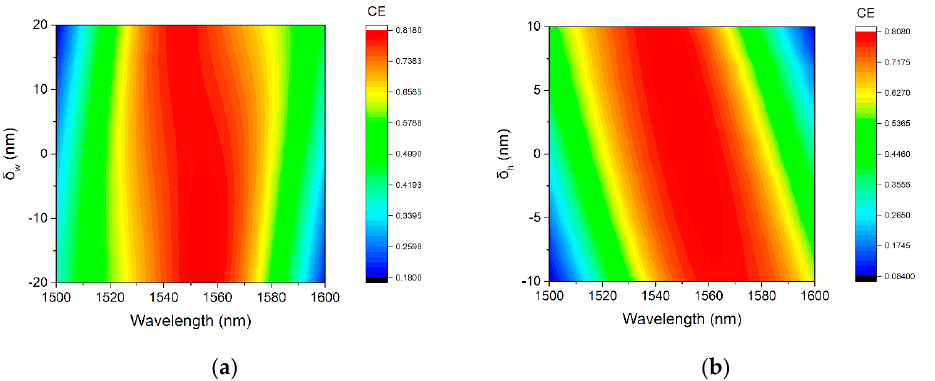
Figure 9. ( a ) Dependence of CE on width errors of the grating tooth. ( b ) Dependence of CE on grating etch depth errors.